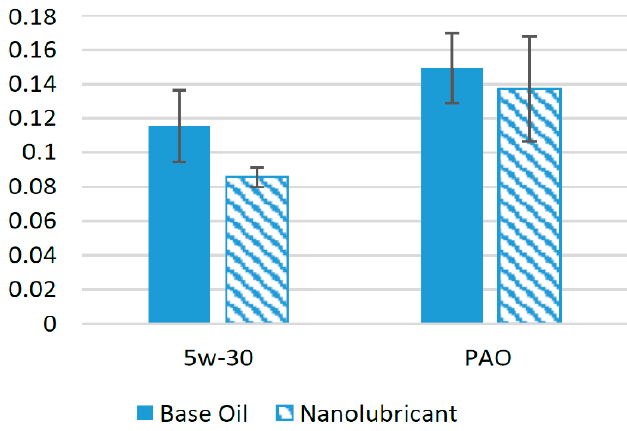
Figure 13. Effect of WS 2 NPs on the friction performance of synthetic lubricants.